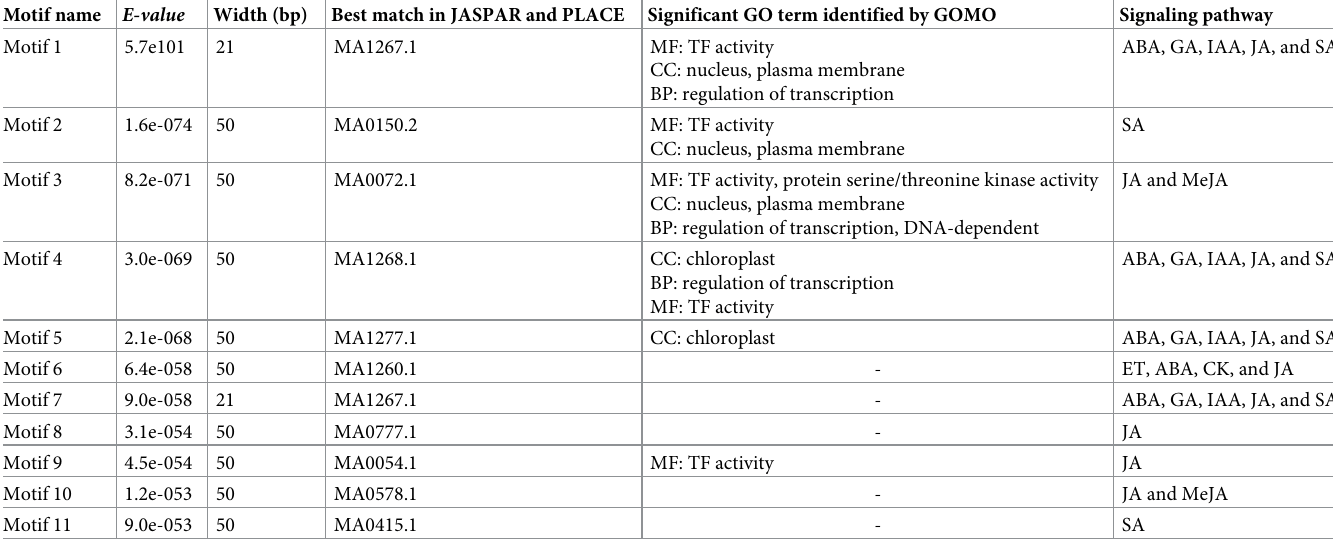
Table 6. The conserved cis-acting elements found in promoter of hormonal DEGs by the MEME